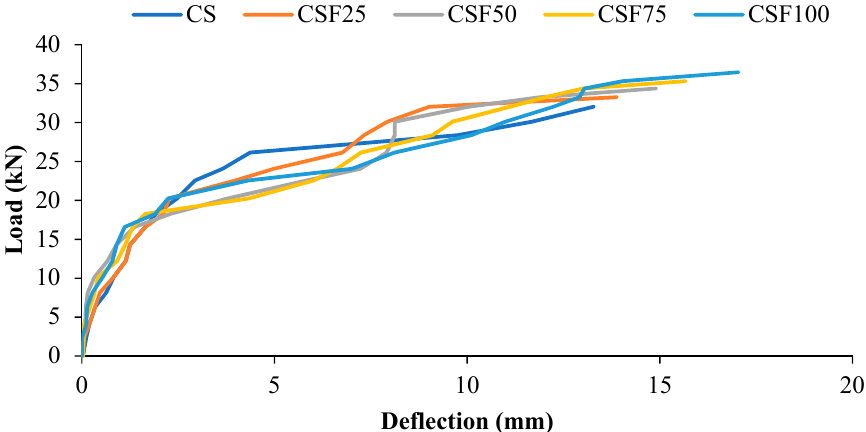
Figure 9. The load–deflection curve of the fiber reinforced-coconut shell concrete mixes.